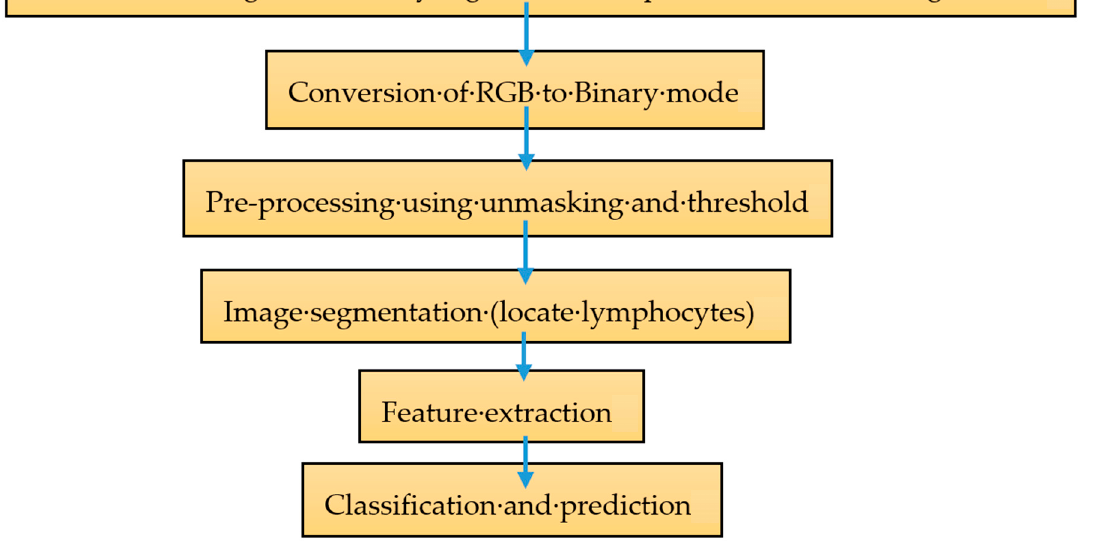
Figure 3. Steps in Methodology .